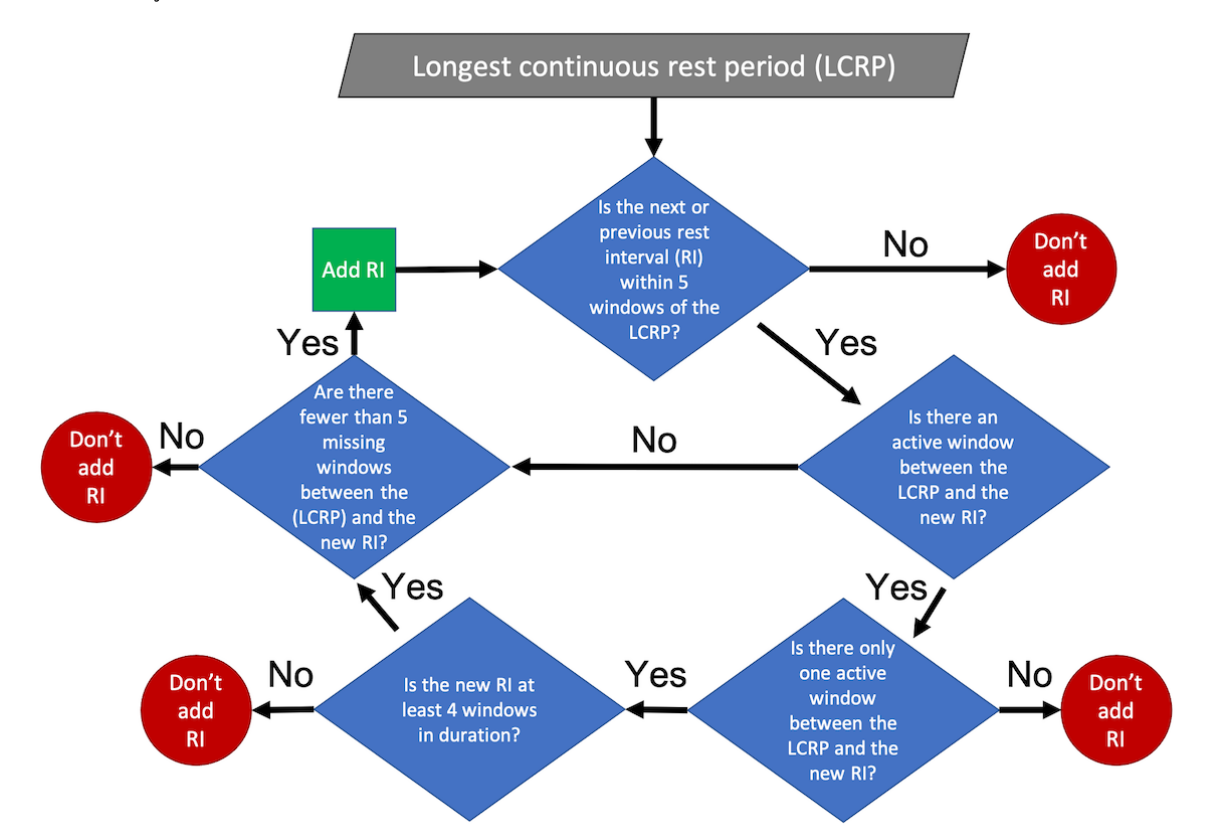
Figure 2. Flowchart for finding the longest rest period. The first step in defining the longest rest period for a given day is to locate the LCRP (ie, the longest duration of consecutive 15-minute rest windows without any active or missing windows). The algorithm described in the flowchart is then used to determine if nearby windows are added to the LCRP.